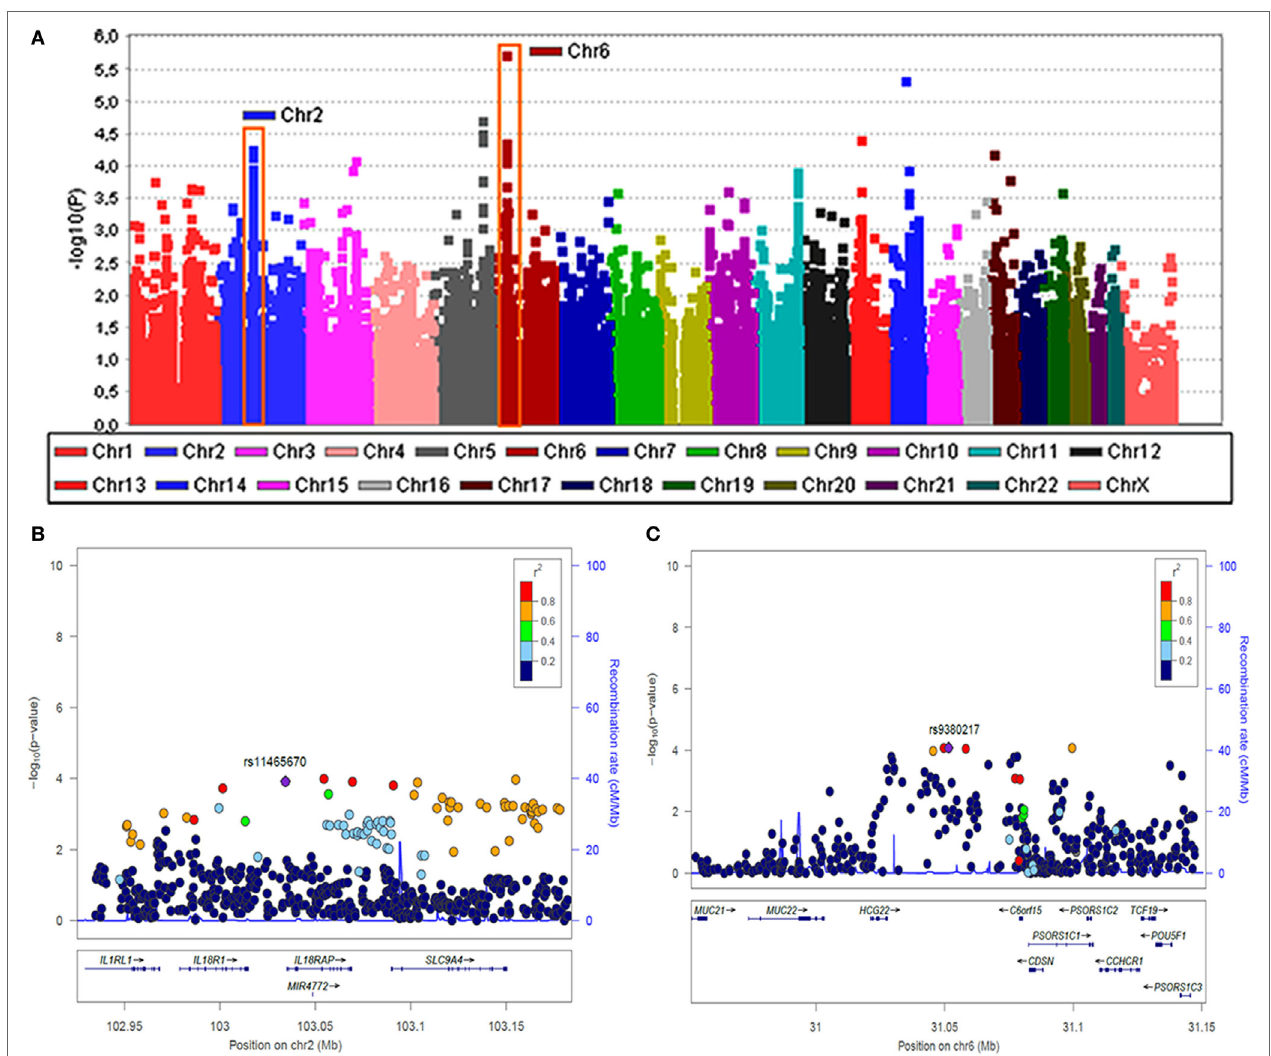
FigUre 1 | Two loci associated with bilateral sensorineural hearing loss (SNHL). (a) Manhattan plot for association study findings from Immunochip genotyped bilateral cases and controls. (B) Association area at the region on chromosome 2 and (c) association area at the region on chromosome 6. Both (B,c) − logP values of single nucleotide variants (SNVs) associated with bilateral SNHL are shown on the left y -axis and the recombination rates expressed in centimorgans (cM) per Mb, are shown on the right y -axis. Positions in Mb are on the x -axis (NCBI Build GRCh38). Linkage disequilibrium for each SNV with the top SNV, displayed as a large purple diamond, is indicated by its color. The plots were drawn using LocusZoom tool (http://locuszoom.sph.umich.edu/locuszoom/).